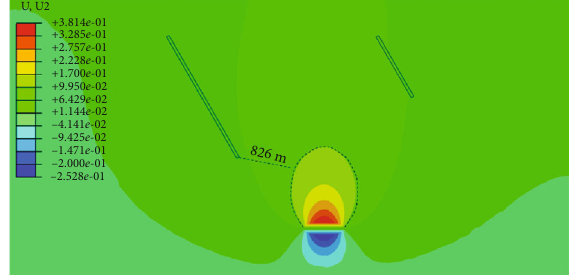
Figure 22: Distribution vertical displacement of when hydraulic fracturing region is N4 (No. C4).